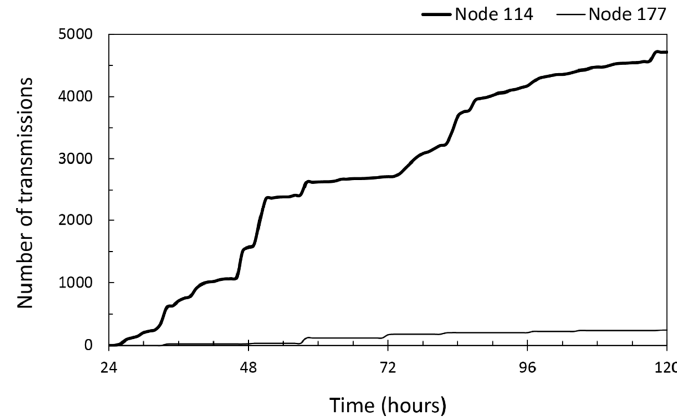
Figure 20. Cumulative number of transmissions for Node 114 and Node 177.